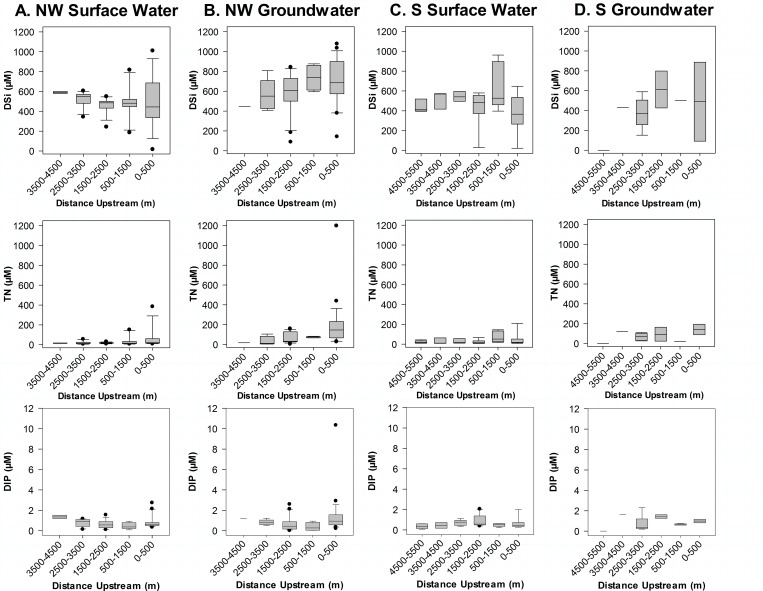
Salinity-corrected DSi, TN, and DIP (μM) boxplots by distance downstream (m) for the Kahaluʻu and Kāneʻohe Stream-Coastal continuums.(A) Surface water and (B) groundwater for Kahaluʻu Stream flowing into the NW sector. (C) Surface water and (D) groundwater for Kāneʻohe Stream flowing into the S Sector.